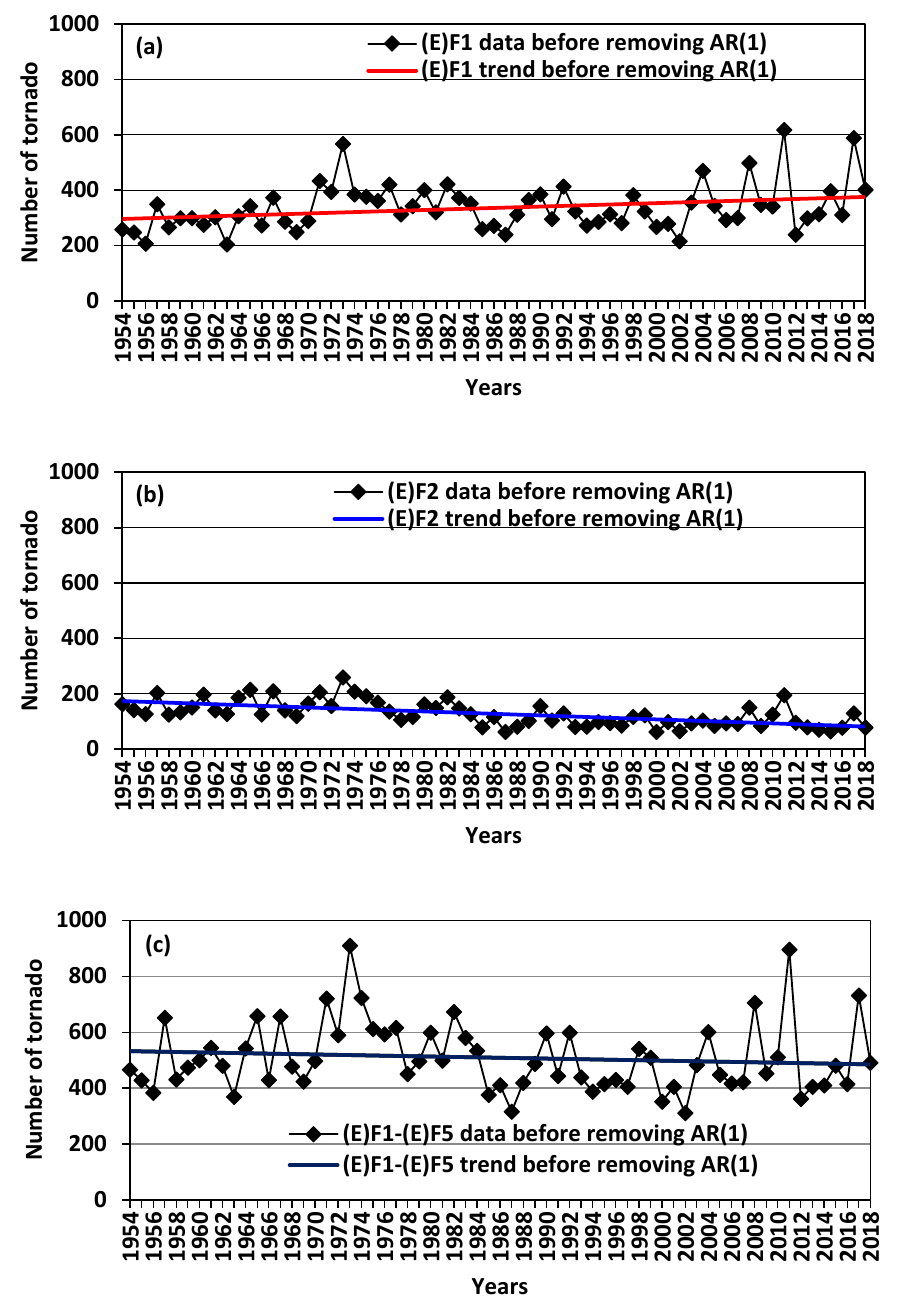
Figure 4. Time series of U.S. tornado counts (1954-2018) and its trend after adjustment associated. with population density for ratio of (E)F1 to (E)F2 in (a) increasing (E)F1 over 1954-1973, (b) de- creasing (E)F2 over 1954-1973, and (c) (E)F1-(E)F5 with (E)F1 in (a) and (E)F2 in (b).